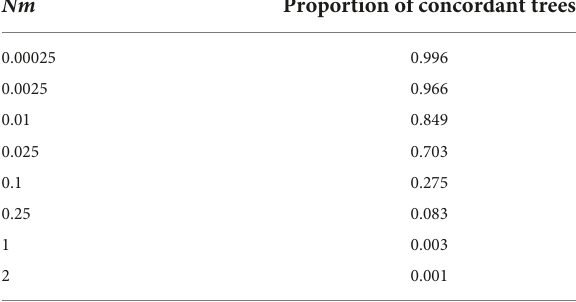
TABLE 3 Results of in silico experiment exploring the importance of migration in generating/preventing the existence of monophyletic groups (concordant gene trees).